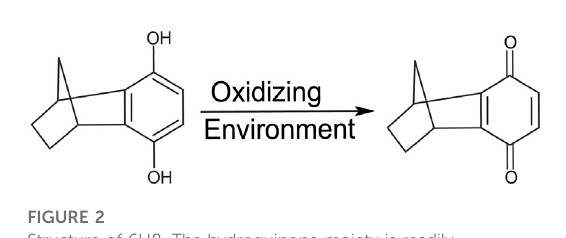
FIGURE 2 Structure of 6H8. The hydroquinone moiety is readily oxidized to its active quinone